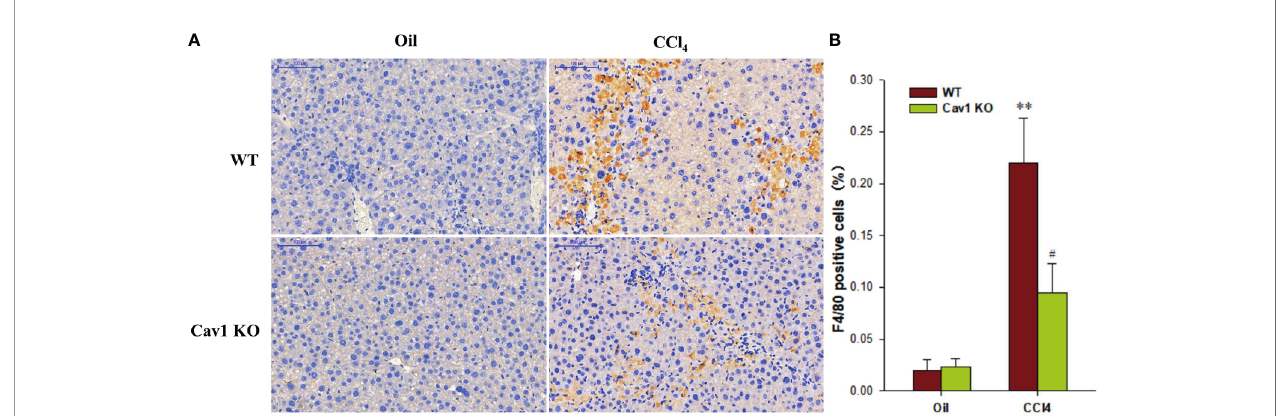
FIGURE 3 | In fi ltration of macrophages was reduced in Cav1 KO mice. Liver tissues were collected from Cav1 KO and WT mice after CCl 4 treatment and stained for F4/80 for 24 h by immunohistochemistry. (A) Representative immunohistochemical staining for F4/80 (yellow). F4/80 antigen is a murine macrophage-speci fi c antigen. Nuclei were counterstained with hematoxylin (blue). (B) The percentage of F4/80 positive cells relative to all cells was measured. Signi fi cantly decreased in fi ltration of macrophages was observed in Cav1 KO mice compared to the WT group at 2 weeks after CCl 4 treatment. Data are shown as mean ± SD, ** p < 0.01 compared with the WT+oil group, # p < 0.05, compared with the WT+CCl 4 group. Scale bar = 100 µm. n=6 per